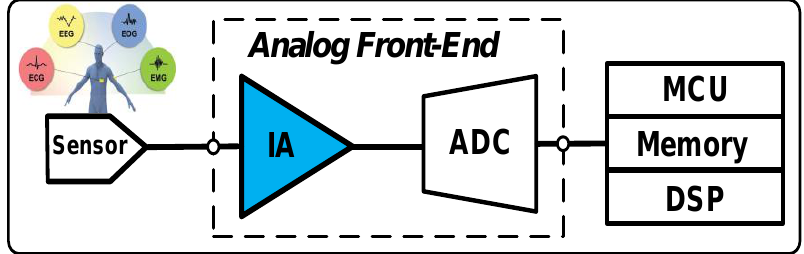
Figure 1. Block diagram of a biopotential acquisition system.